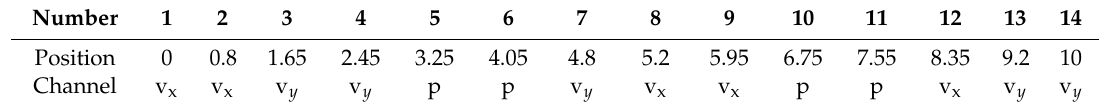
Table 2. Array element positions of the vector hydrophone array optimized by CS.